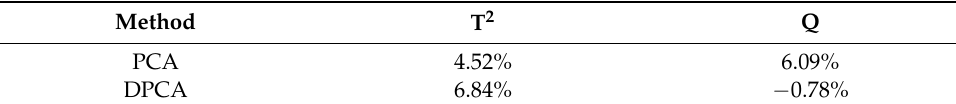
Table 4. GA-DPCA average improvement rate of accurate diagnosis.